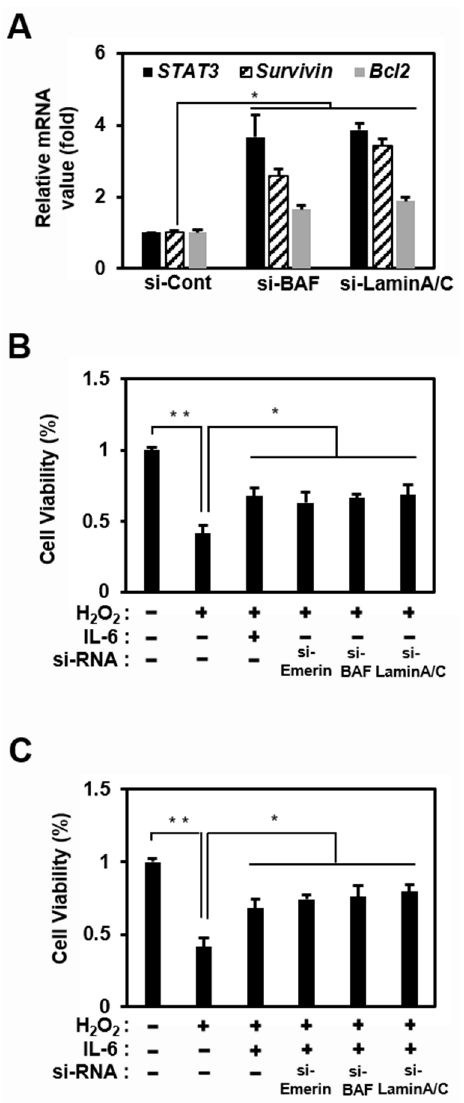
Figure 3. The emerin network modulates STAT3 signaling and survival in HeLa cells. ( A ) HeLa cells were treated with siRNA (100 nM) against BAF, Lamin A/C, or control for 48 h in 6-well plates. Total RNA was isolated and subjected to qRT-PCR analysis. Data were normalized to GAPDH expression. The results are presented the mean ± SD of three independent experiments performed in triplicate. * p < 0.05. ( B , C ) HeLa cells were treated with siRNA (100 nM) against Emerin, BAF, or lamin A/C in